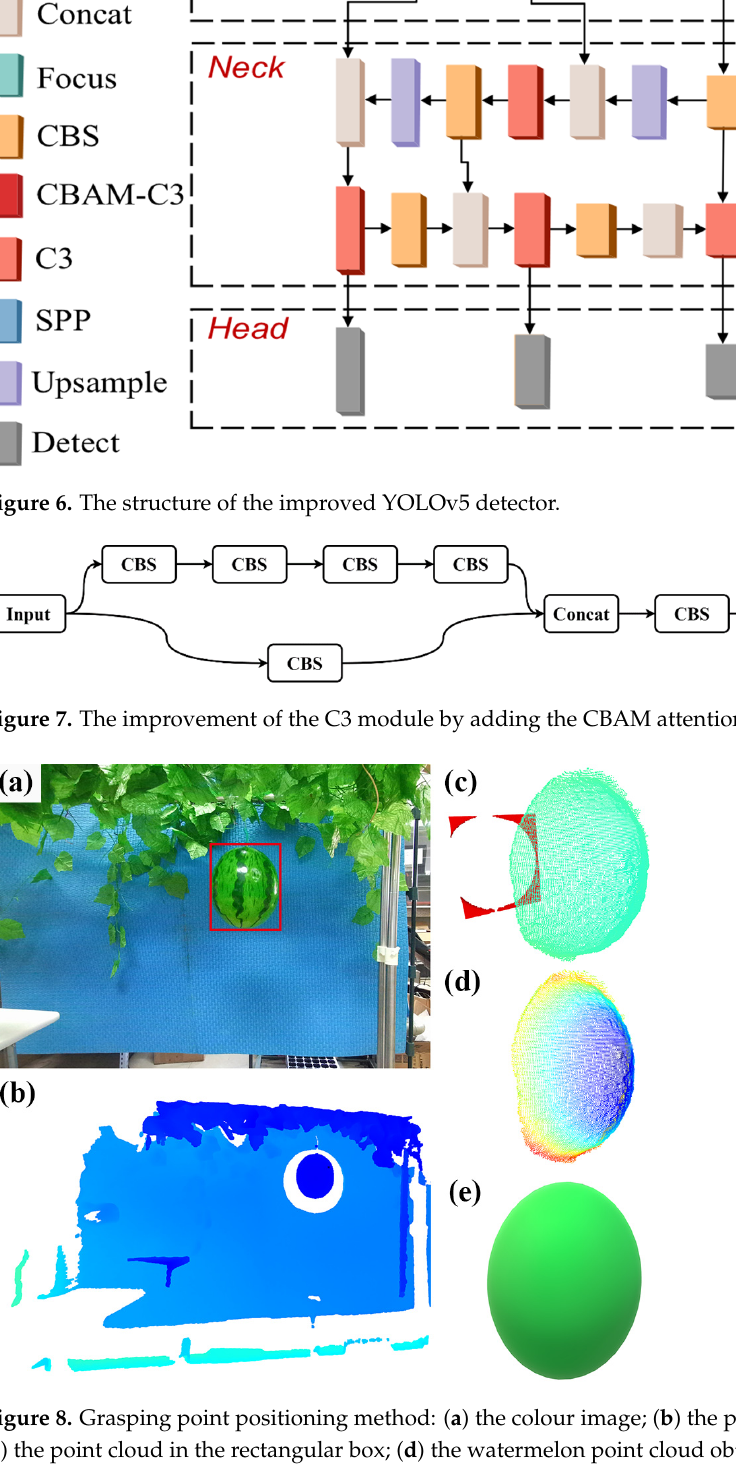
Figure 6. The structure of the improved YOLOv5 detector.